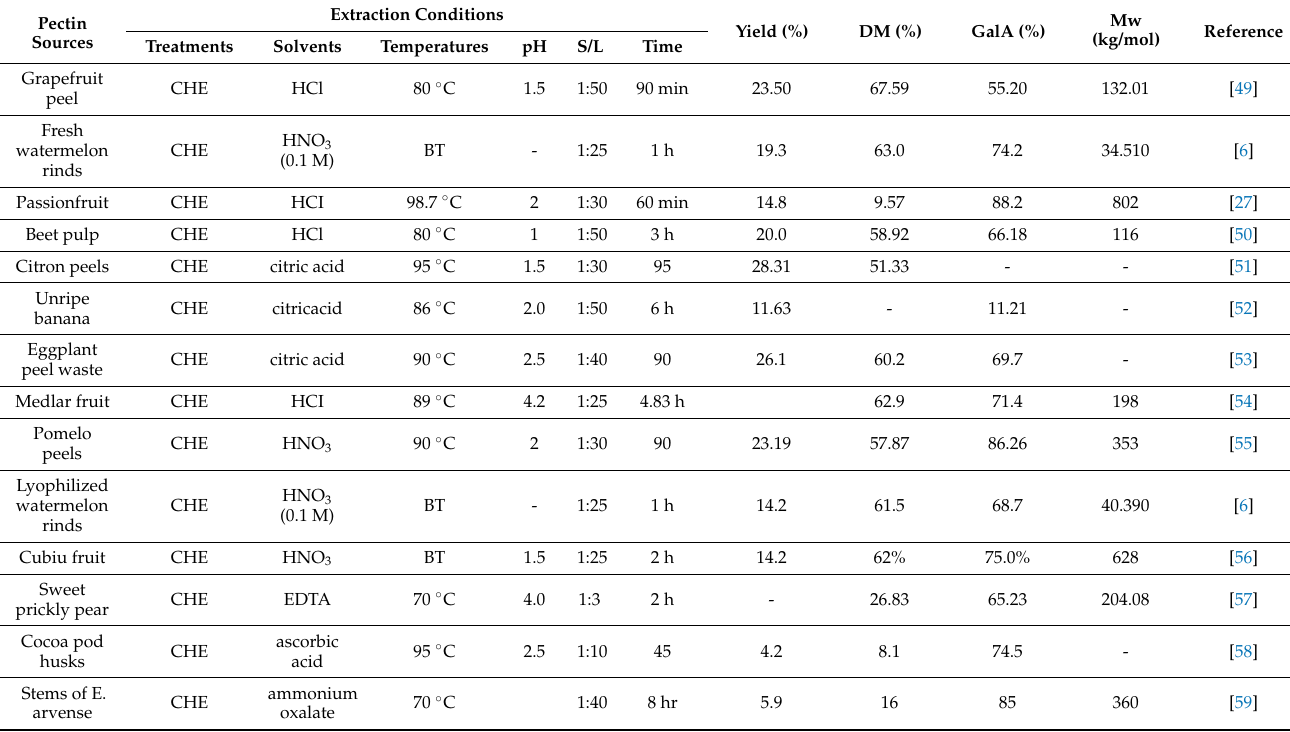
Table 1. Extraction conditions and physico-chemical properties of pectin extracted by CHE from agricultural waste, food by-products, and